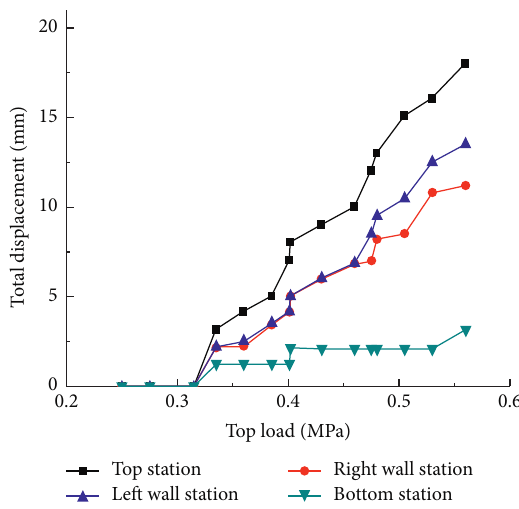
Figure 13: Unsupported model load-displacement curve.